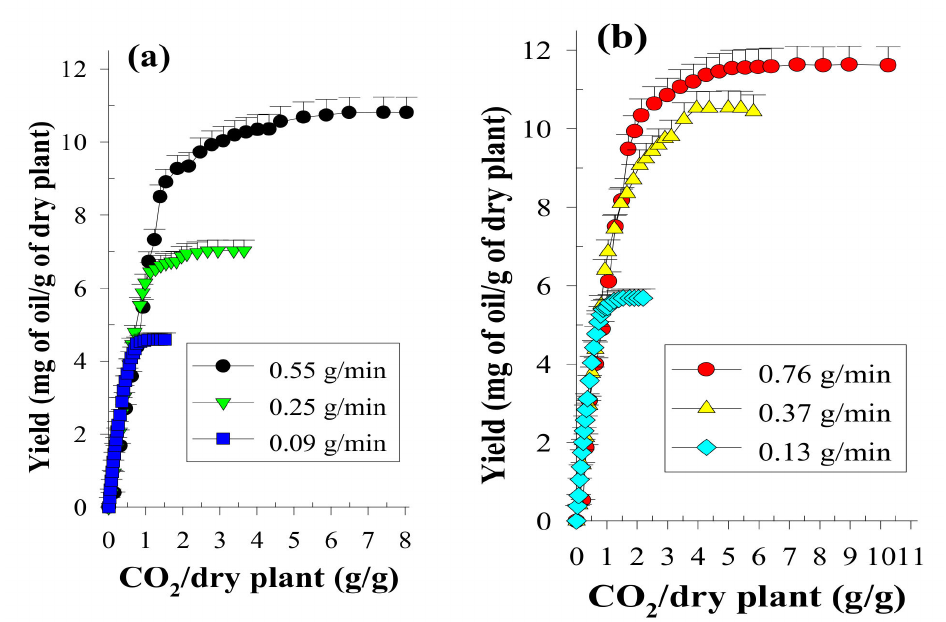
Figure 1. Overall extraction curves at 32 ◦ C, 33.0 MPa and various CO 2 flow rates ( a , b ) for the SC CO 2 extraction of volatile oils from P. frutescens leaves.